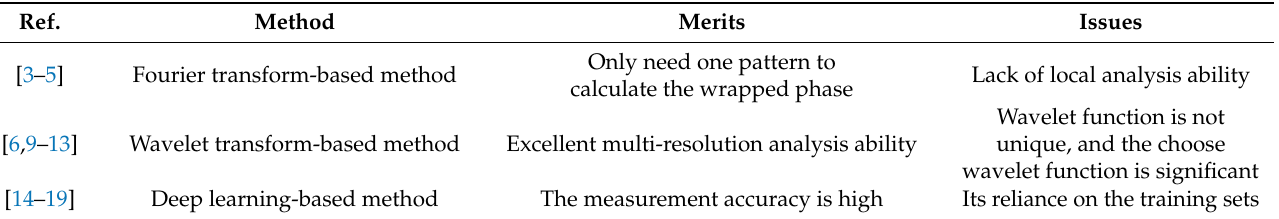
Table 1. Merits and issues of current 3D reconstruction